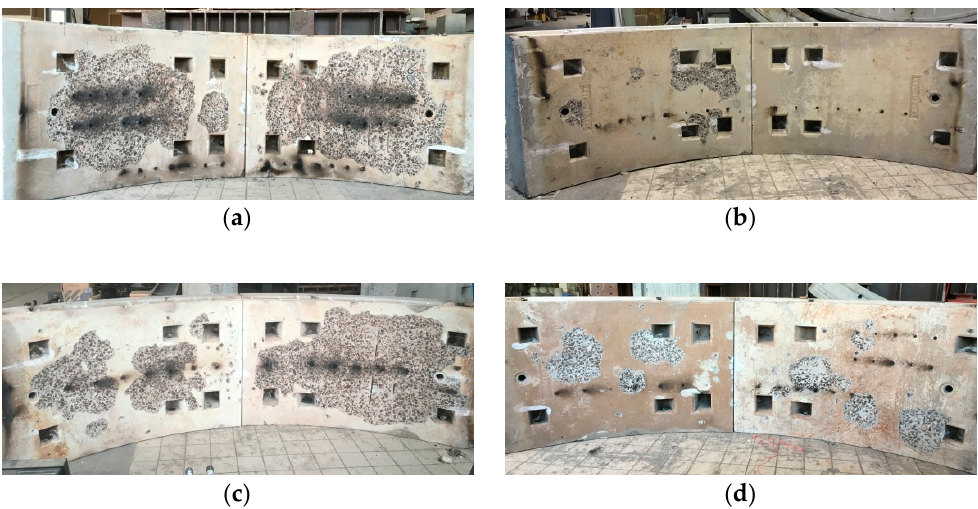
Figure 7. Concrete spalling after fire exposure (MESD: maximum explosive spalling depth in mm; SAR: ratio of the spalled area to the area of the specimen’s soffit). ( a ) Specimen S60 (MESD=48.5, SAR=45.7%); ( b ) specimen S60C (MESD=29.1, SAR=5.5%); ( c ) specimen S120 (MESD=56.2, SAR=38.8%); ( d ) specimen S120C (MESD=25.6, SAR=17.2%).